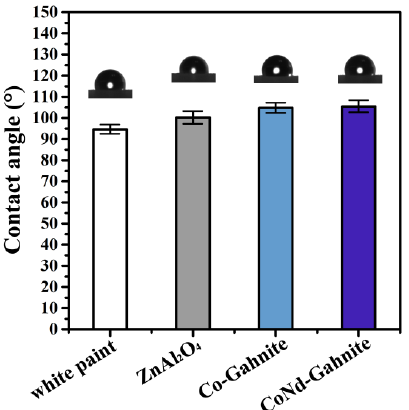
Figure 8 . Histogram showing the contact angle values of the pigment in coatings applied on a pol- ycarbonate substrate.